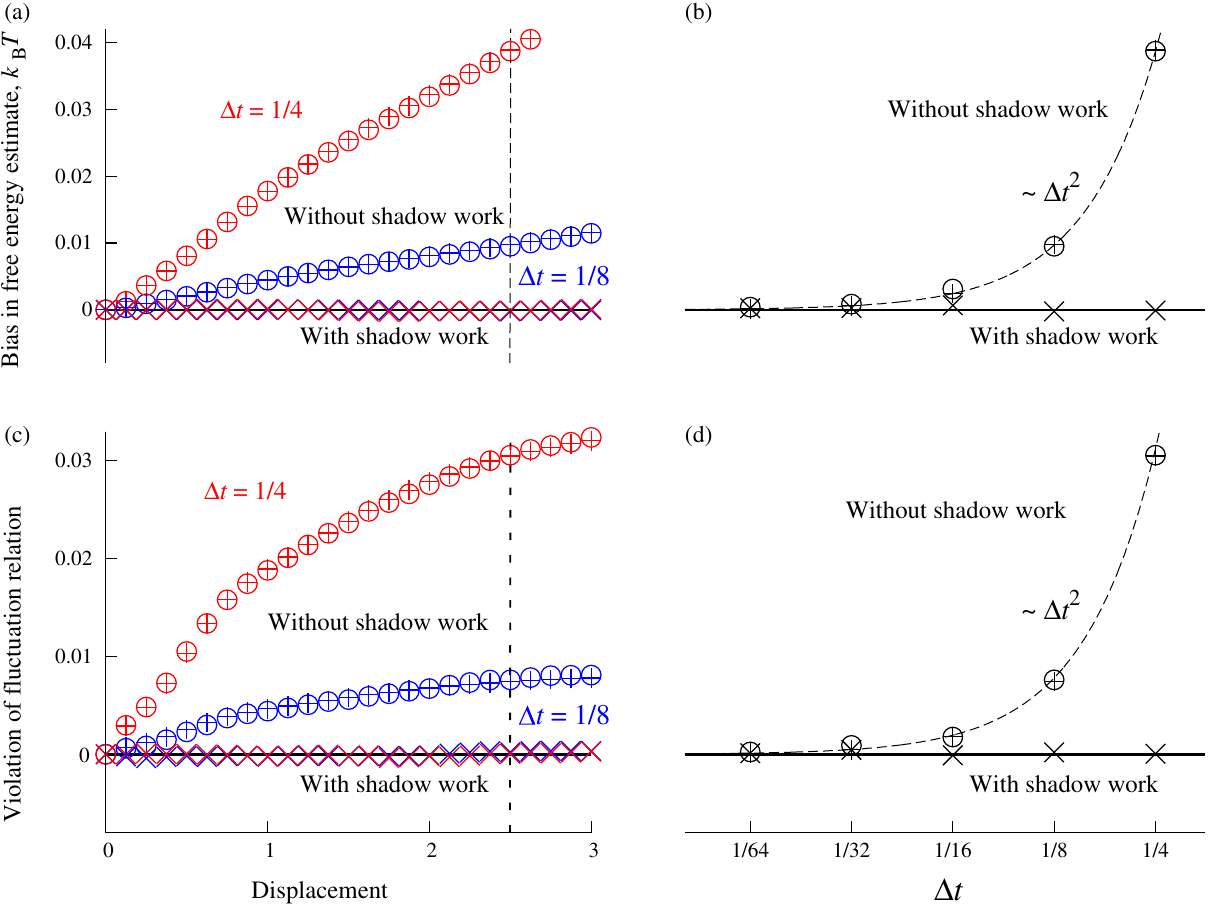
FIG. 3. Ignoring shadow work in Langevin simulations leads to systematic errors in inference of both equilibrium and nonequilibrium ð x (cid:1) x min Þ 4 uniformly statistics. Results are from Langevin simulations of 10 8 independent realizations of a quartic potential U ¼ 1 4 translating with velocity 1 = 2 , starting from equilibrium, with unit temperature, mass, spring constant, and friction coefficient. Standard errors are smaller than symbol size. The y axes for (b) and (d) are the same as those for (a) and (c), respectively. (a) Error in free energy calculated from the Jarzynski equality (10a) as a function of position of the quartic potential, neglecting shadow work (circles) and including shadow work ( (cid:6) s), for (cid:1) t of 1 = 4 (red) and 1 = 8 (blue). The exact change in free energy is zero. The error in the naı¨ve Jarzynski estimator (circles) is entirely captured by the correction term (cid:1) ln h e (cid:1) (cid:2)W shad i ~(cid:2) ( þ signs) from Eq. (12), as can be seen by the agreement of these symbols to within statistical error. (b) Semilog plot of error in the Jarzynski estimate of free energy after the quartic potential has moved to r ¼ 2 : 5 , as a function of time-step length, neglecting shadow work (circles) and including shadow work ( (cid:6) s). Also shown is the correction term from Eq. (12) ( þ signs). (c) Ratio of left-hand side and right-hand side of the ITFT as a function of position of the quartic potential, neglecting shadow work [circles, Eq. (15)] and including shadow work [ (cid:6) s, Eq. (13)], for (cid:1) t of 1 = 4 (red) and 1 = 8 = h e (cid:1) (cid:2)W prot i ( þ signs), as can be (blue). The error in the naı¨ve ITFT ratio is entirely captured by the correction factor h e (cid:1) (cid:2)W tot i W prot > 0 W prot > 0 seen by the agreement of these symbols to within statistical error. (d) Semilog plot of the ITFT ratio after the quartic potential has moved to r ¼ 2 : 5 , as a function of time-step length (cid:1) t , neglecting shadow work (circles) and including shadow work ( (cid:6) s). Also shown is the = h e (cid:1) (cid:2)W prot i ( þ correction factor h e (cid:1) (cid:2)W tot i W prot > 0 W prot > 0